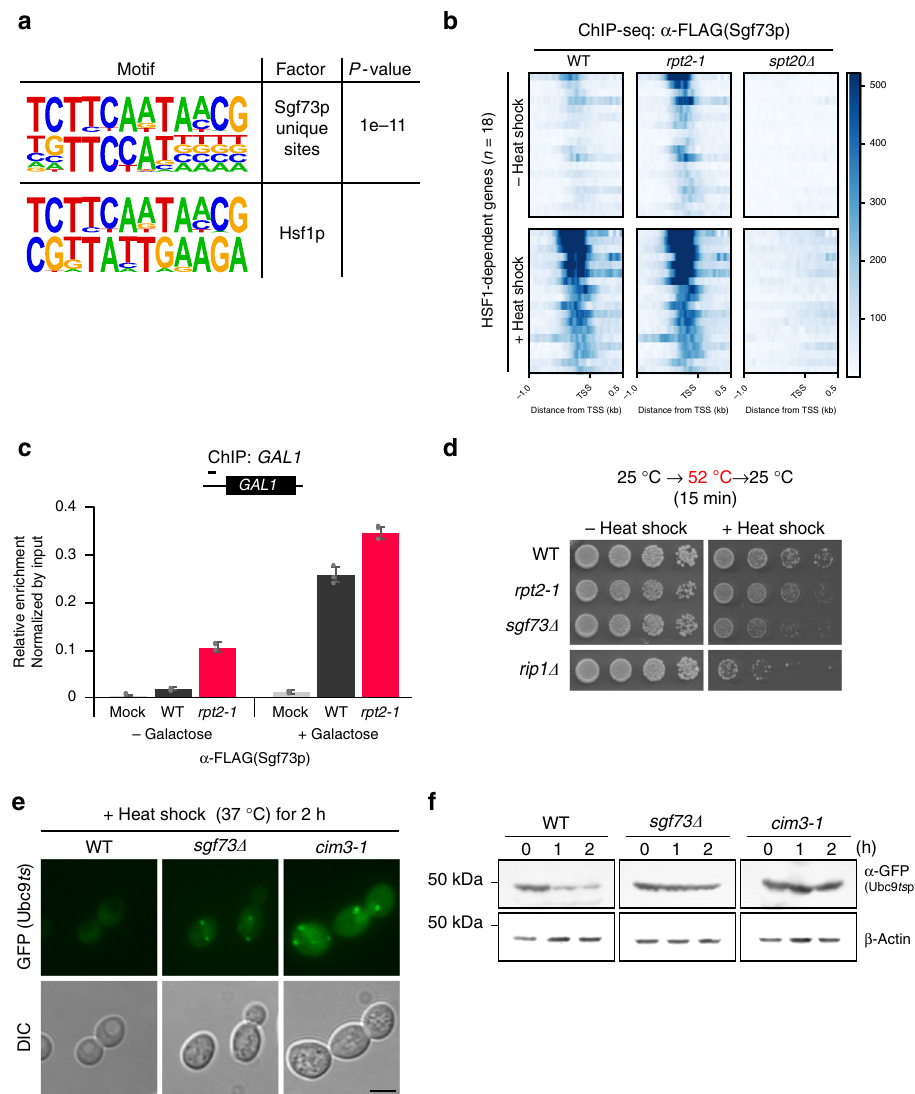
Fig. 5 Sgf73p is required for heat shock survival and proteostasis. a (Upper panel) De novo motif enrichment analysis of Sgf73p-binding sites was performed using HOMER. (Lower panel) Comparison of the Sgf73p-binding motif with known motifs showed signi fi cant correspondence with the Hsf1p- binding motif. b Heatmaps of ChIP-seq signals representing Sgf73p-binding ( α -FLAG) in wildtype, rpt2-1 , and spt20 Δ cells, from 1 kb upstream to 0.5 kb downstream of the TSS regarding Hsf1-dependent genes ( n = 18) before and after heat shock. Heatmaps were sorted in descending order of Sgf73p enrichment. The y -axis color scale indicates normalized ChIP-seq read count. c ChIP-qPCR analysis against Sgf73p ( α -FLAG) of the GAL1 gene before and after galactose induction in mock, wildtype, and rpt2-1 cells. d Cell survival analysis after heat shock was assessed by spotting assays. Wildtype, rpt2-1 , and sgf73 Δ cells were subjected to heat shock at 52 °C for 15 min, plated on YPD medium in fi ve-fold serial dilutions, and incubated at 25 °C for 3 days. e Visualization of GFP-Ubc9 ts by fl uorescence imaging. Wildtype, rpt2-1 and sgf73 Δ cells carrying the galactose-inducible GFP-Ubc9ts construct were subjected to heat shock at 37 °C for 2 h, and then fi xed and imaged. Scale bar, 5 μ m. f GFP-Ubcp9 ts protein levels ( α -GFP) in wildtype, rpt2-1 , and sgf73 Δ cells subjected to heat shock were assessed by Western blotting. β -Actin was used as a loading control. Standard deviations of three